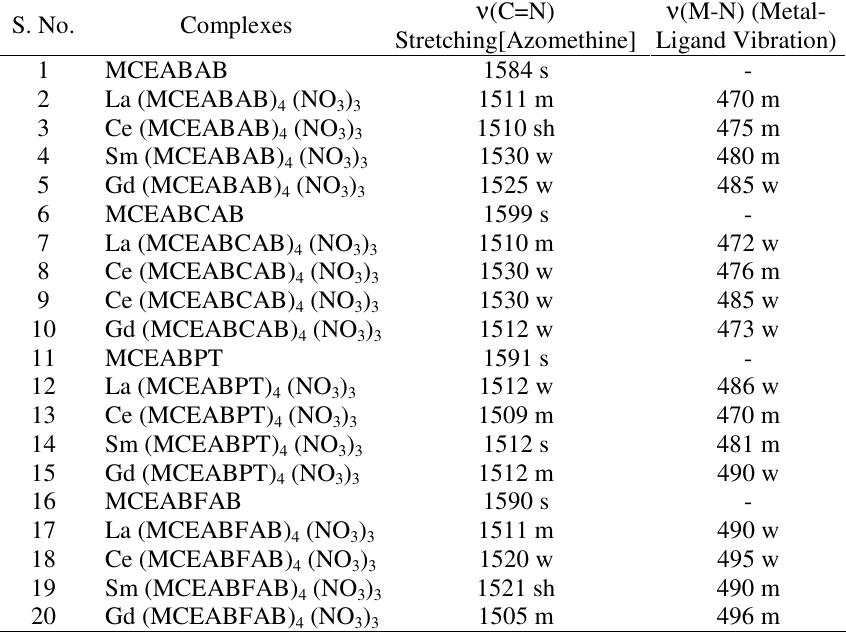
Table 3. Partial IR spectral data for lanthanide(III) nitrate complexes of Schiff base ligands S.